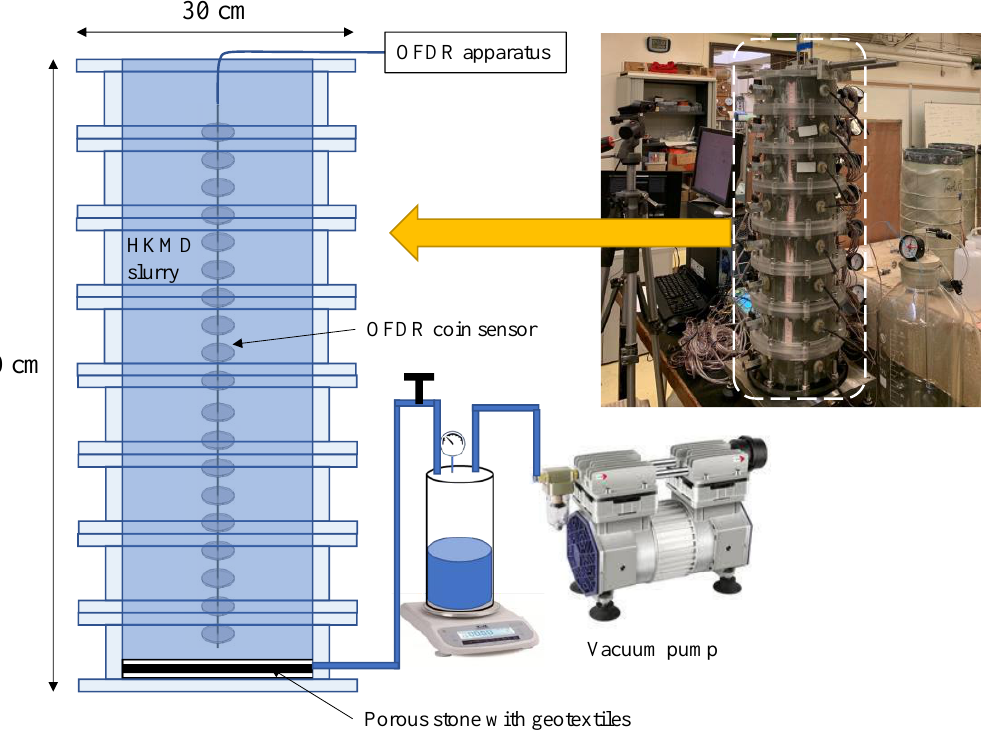
Figure 9. Schematic diagram of the small physical model test.